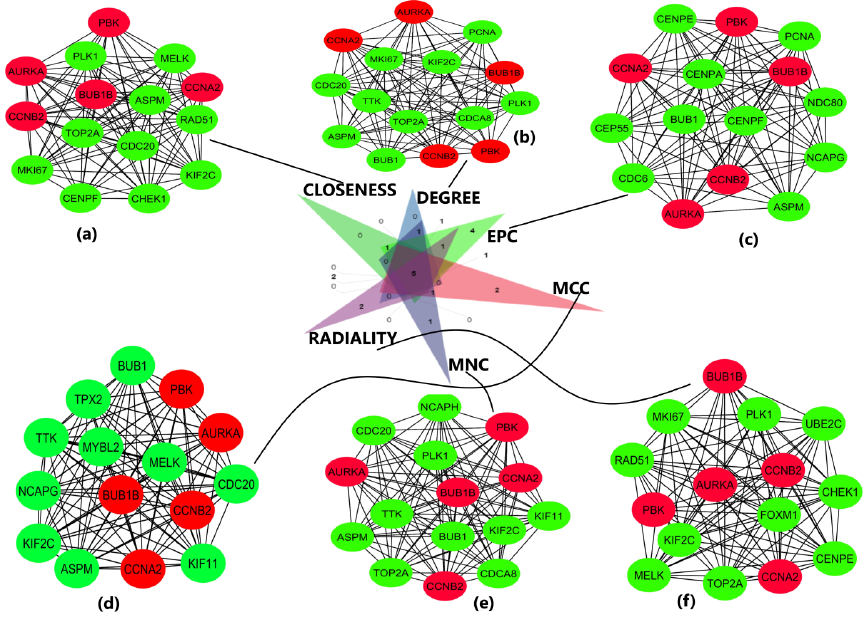
Figure 4. Important sub-networks and nodes obtained from cytohubba plug-in of Cytoscape soft- ware using six topological algorithms. The top 15 hub genes were evaluated in the PPI network using these six calculation methods. Red color circles represent the hub genes of interest in this study, and green color circles represent the adjoining genes obtained from network. ( a ) Sub-network obtained from closeness topological algorithm. The nodes in red represent the top-ranked hub genes. ( b ) Sub-network and hub genes obtained from degree topological algo- rithm. ( c ) Sub-network and hub genes obtained from EPC topological algorithm. ( d ) Sub-network and hub genes obtained from MCC topological algorithm. ( e ) Sub-network and hub genes obtained from MNC topological algorithm. ( f ) Sub-network and hub genes obtained from radiality topo- logical algorithm. The hub genes are shown in red color in all 6 topologies. Table 1. The values of hub genes for various topological algorithms of cytohubba.